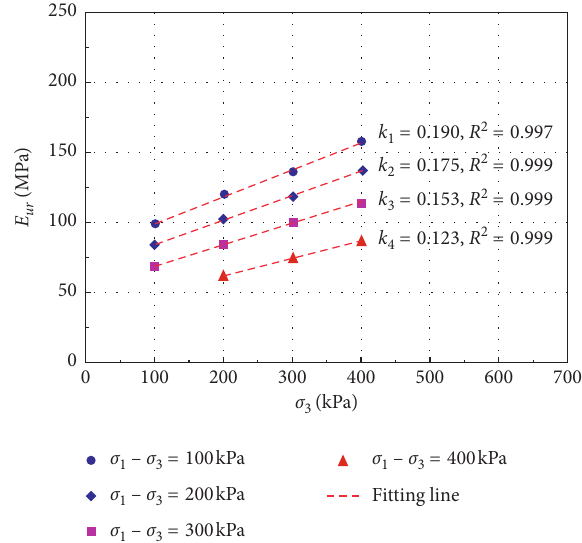
sec- 1 - σ 3 ; (b) E sec- 2 - σ 3